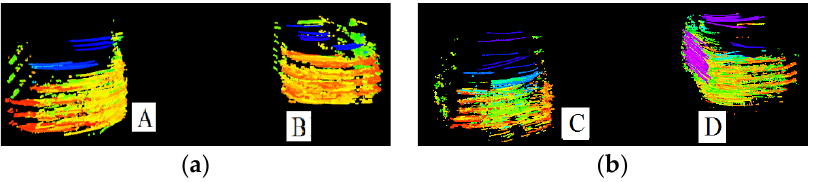
Figure 3. Visual effect of the geometric verification of extracted descriptors using SegMatch: ( a ) ob- ject A and object B in the source cloud; and ( b ) object C and object D in the target cloud.